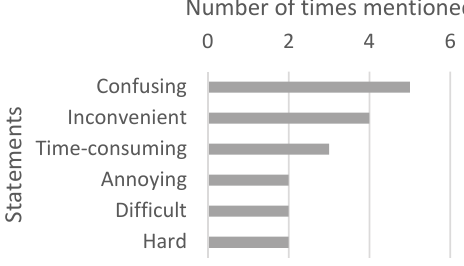
Figure A7. Opinion on recycling in three words, all negative statements mentioned more than once, first survey (106 individuals).